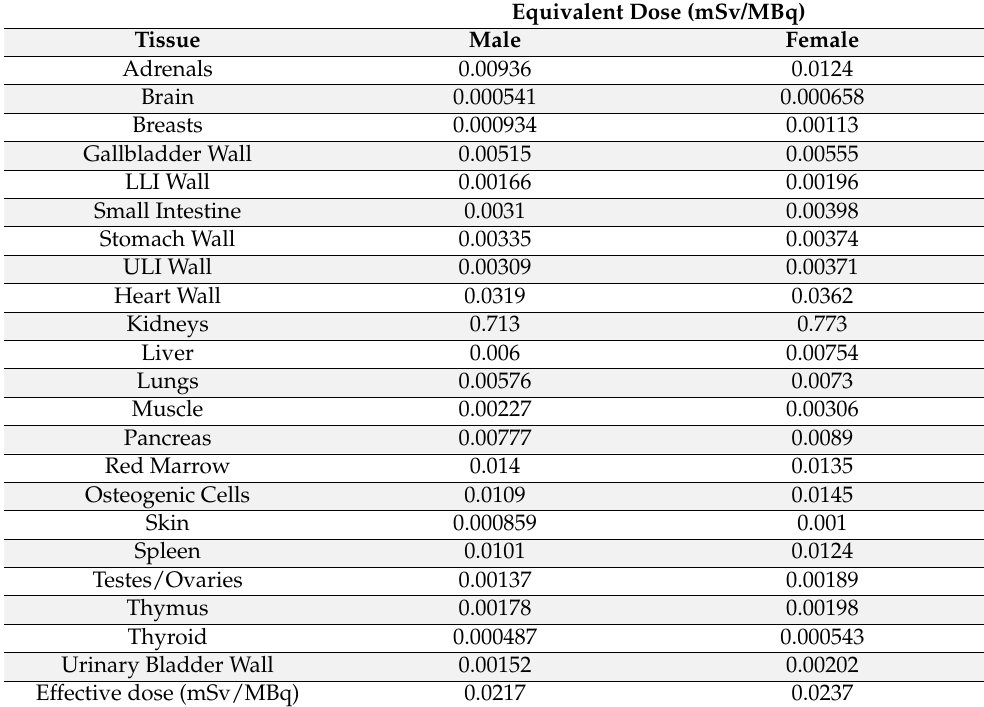
Table 3. Estimated organ equivalent doses (mSv/MBq) of [ 68 Ga]Ga-C803-GIP in human females and males extrapolated from the rat organ distribution